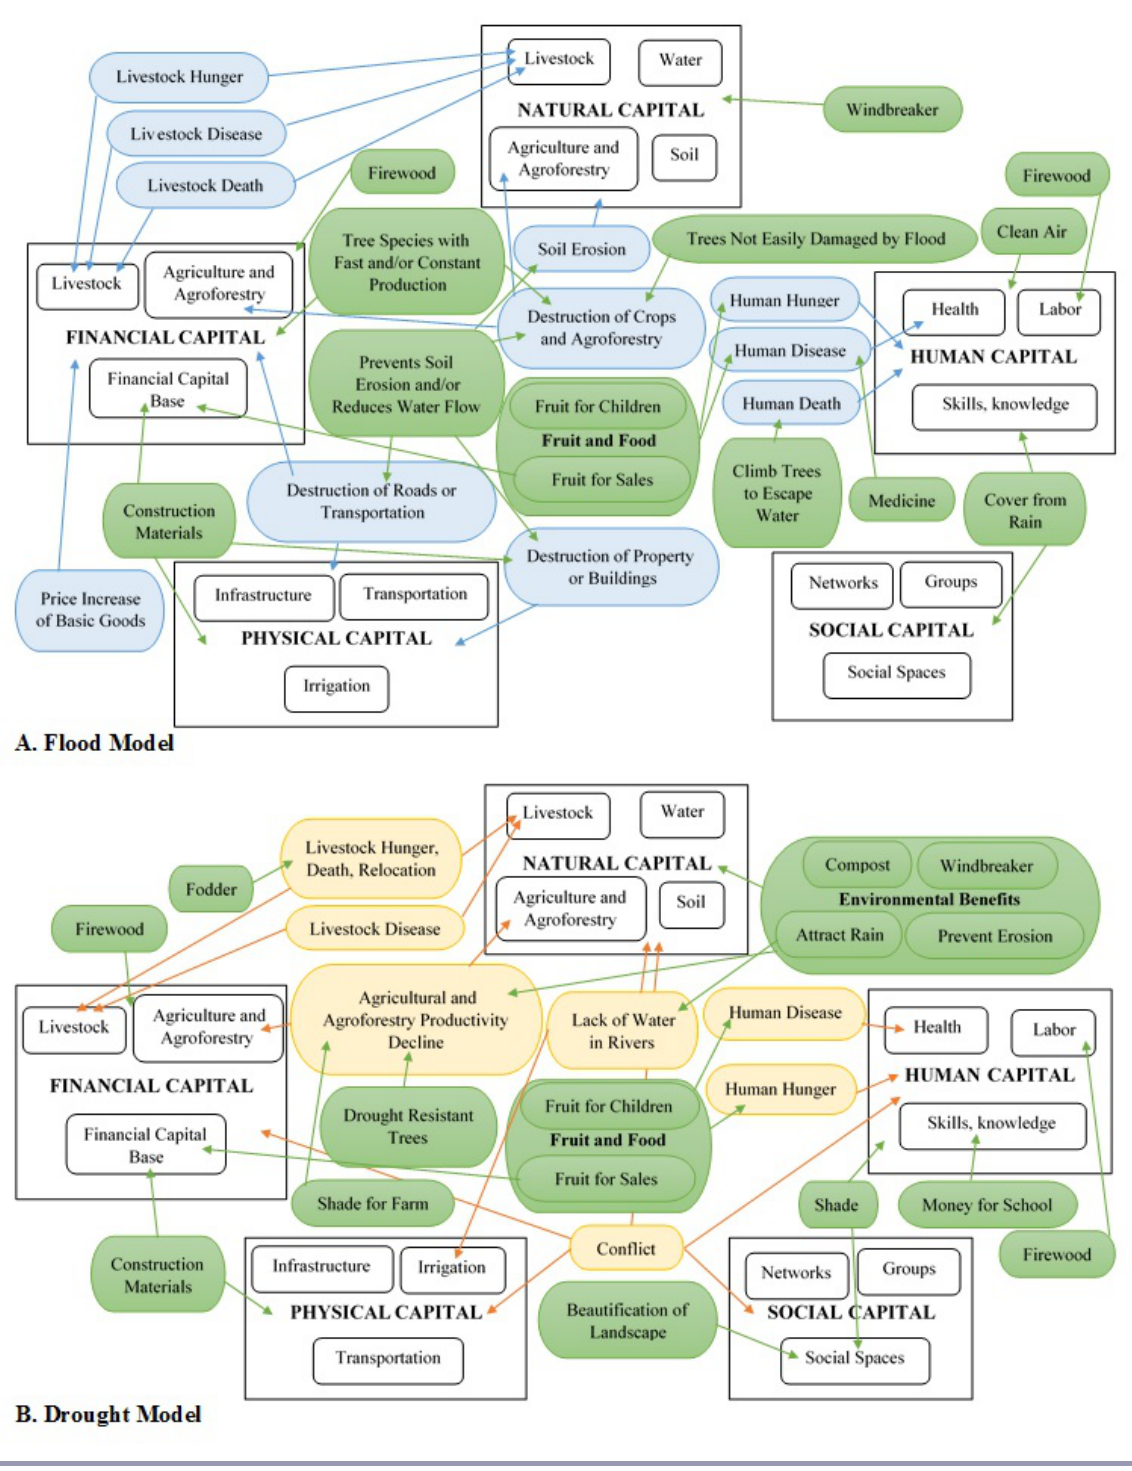
Fig. 5. Frameworks showing effects of floods (A) and drought (B) on five livelihood capital assets, and the benefits of trees. The depicted relationships were derived from household case study interviews. Colored bubbles represent different themes that arose during the interviews: orange = drought, blue = floods, green = agroforestry